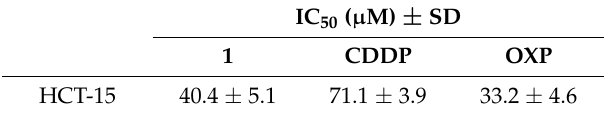
Table 2. Cytotoxicity towards human HCT-15 cancer cell spheroids.